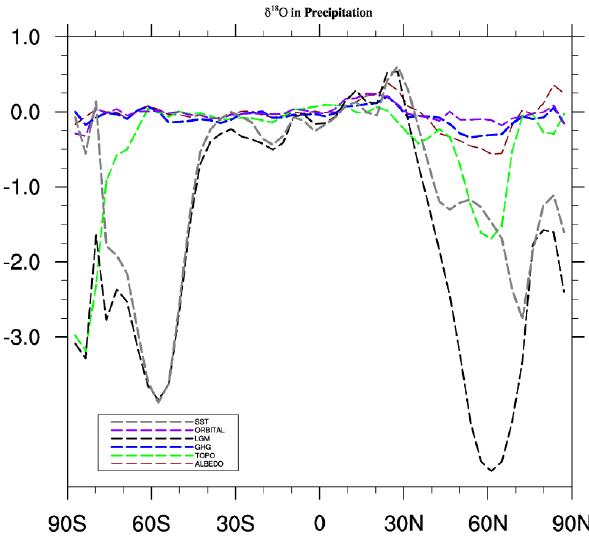
Fig. 2. The difference of zonal mean δ 18 O precip (‰) of each exper- iment from the control